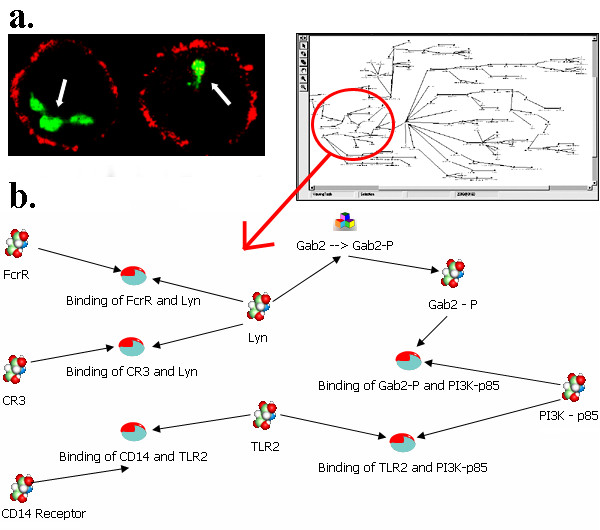
Figure 5a- Phagocytosis of bacteria in macrophages. The picture shows macrophages ingesting green fluorescent mycobacteria (indicated by arrows). The host cell membrane was stained by red fluorochorme PKH to define the limit of the cell. (The picture was provided by Zakaria Hmama)Figure 5b- A SN-representation of the cell signaling network that regulates phagocytosis in the human macrophage. Both molecules and their interactions (non-covalent and covalent interactions) are represented as semantic agents and visualized as nodes (with distinct icons) on the diagram. Arrows represent the semantic relationships between different agents.